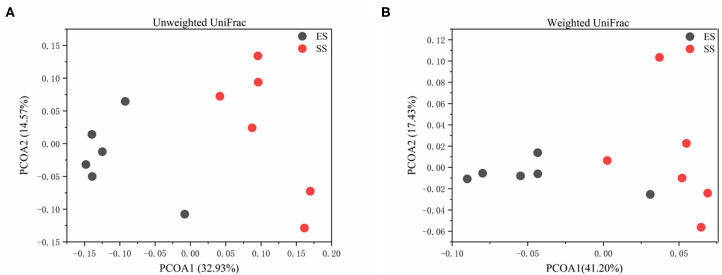
The principal coordinate analysis of rumen microbiota based on unweighted (A) or weighted UniFrac (B) dissimilarities between juvenile and sub-adult Tibetan sheep.